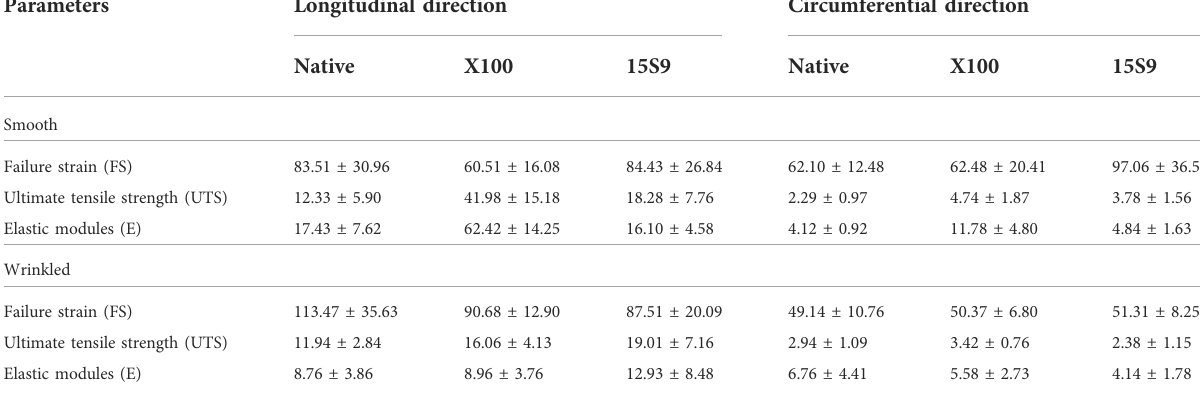
TABLE 2 Biochemical properties of native and decellularized porcine smooth and wrinkled SIS.